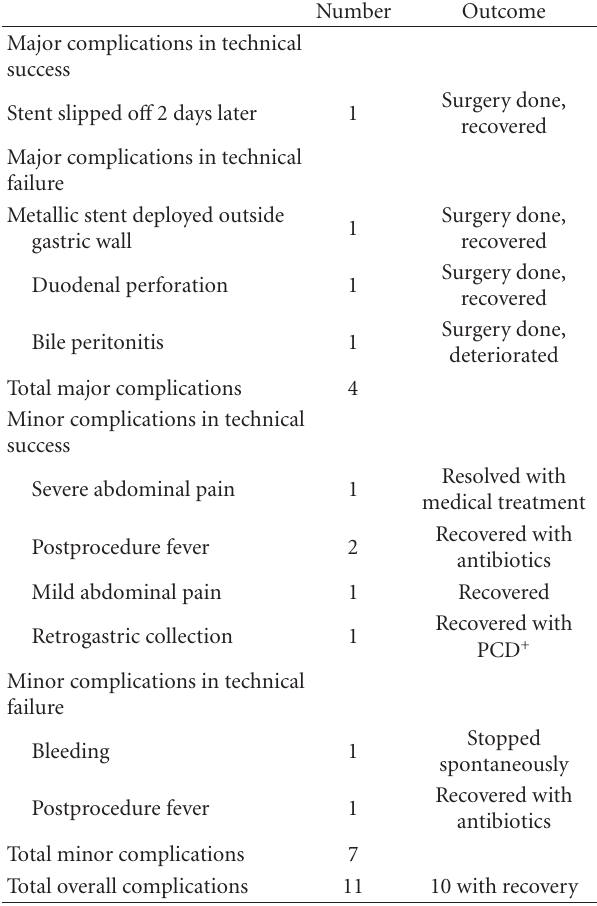
Table 3: Complications, treatment, and